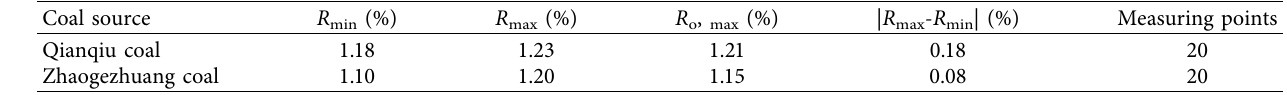
Table 5: Analysis results of vitrinite reflectance ratio in different coal samples.